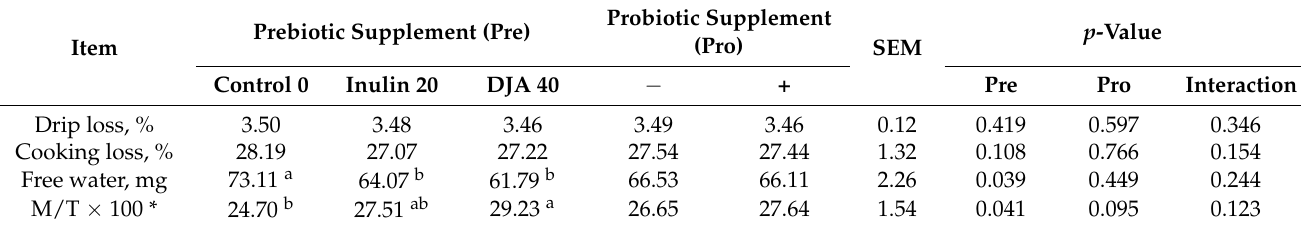
Table 7. Parameters of water-holding capacity and texture of meat (m. longissimus lumborum).